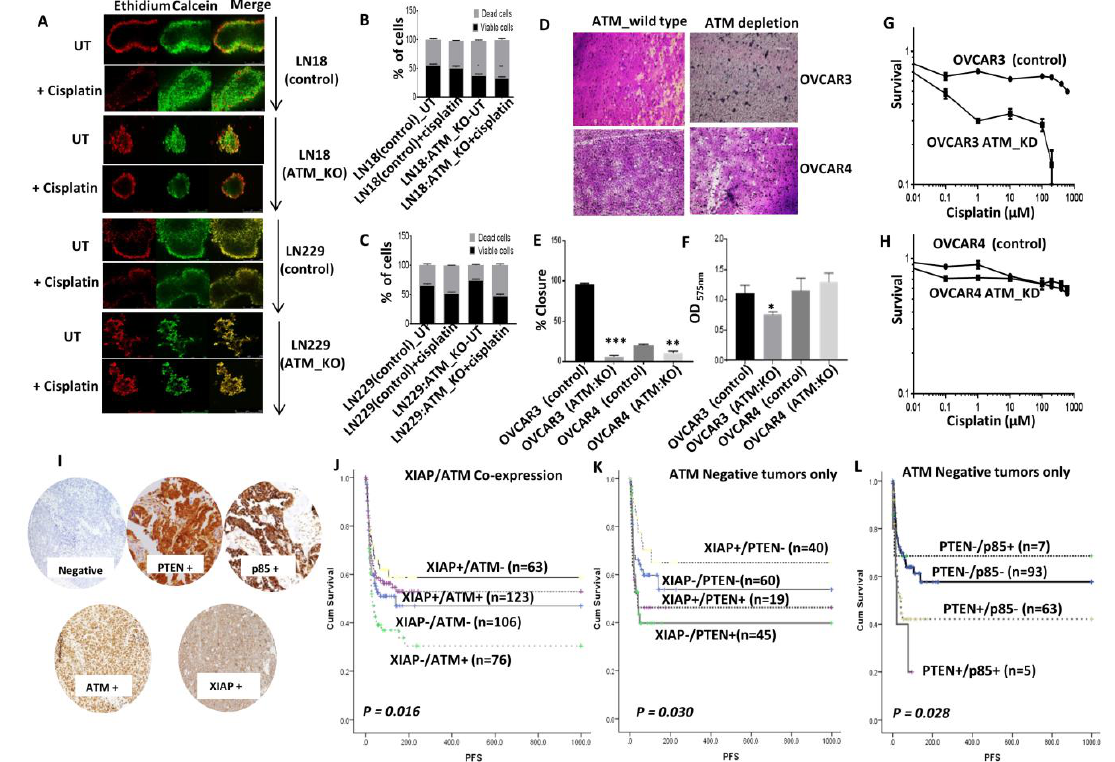
Figure 6. Clinicopathological significance of ATM, PTEN, p85 α , and XIAP in ovarian cancers. ( A ) Representative photo micrographic images of LN18, LN229 cells control and ATM KO cells 3D-neurospheres treated with Cisplatin (40 µ M). ( B ) Quantification of viable / dead cells by flow cytometry in LN18 control and ATM KO cells. ( C ) Quantification of viable / dead cells by flow cytometry in LN229 control and ATM KO. ( D ) Representative figure for Invasion assay in OVCAR3 and OVCAR4 control and ATM_KD. ( E ) Percentage closure quantification by imageJ software. ( F ) Invasion quantification in OVCAR3 and OVCAR4 control and ATM_KD. ( G ) Cisplatin sensitivity in OVCAR3 ATM_KD cells. ( H ) Cisplatin sensitivity in OVCAR4 ATM_KD cells. ( I ) Immunohistochemical expression in ovarian carcinoma TMA cores: Negative control, high PTEN, high P85, high ATM and high XIAP (200 × magnification). Kaplan-Meier curve for PFS ovarian cancers of ( J ) XIAP and ATM co-expression. ( K ) XIAP and PTEN co-expression in ATM negative tumors. ( L ) PTEN and p85 co-expression in ATM negative tumours. * p value < 0.05, ** p value < 0.01, *** p value <